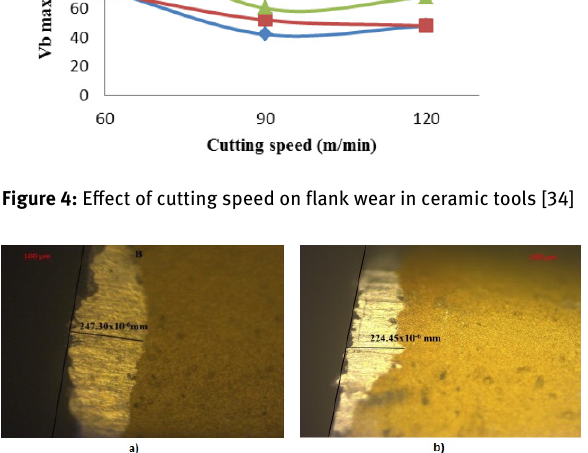
ting speed values (i.e. 600 - 3000 m/min) were